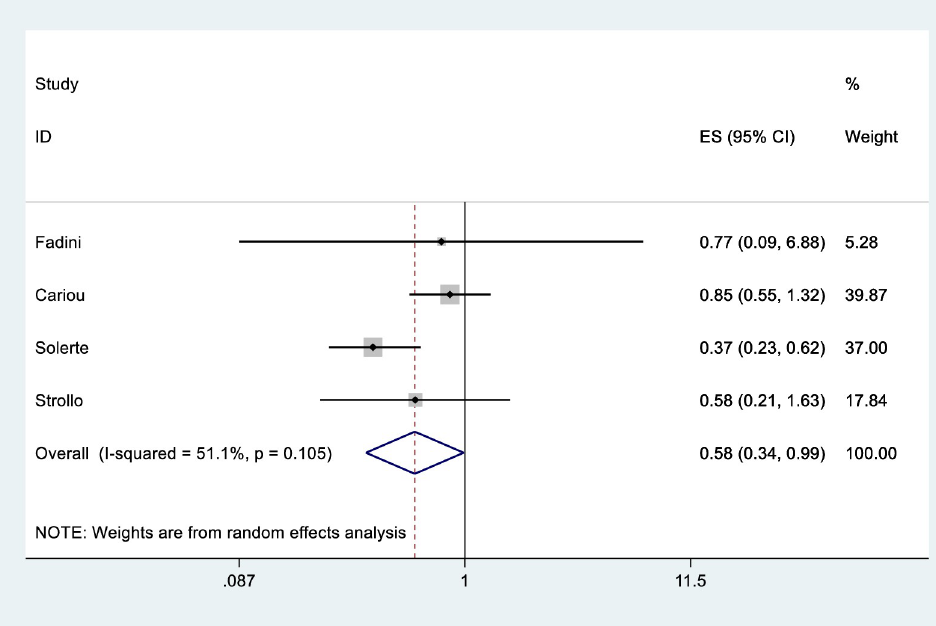
Fig 2. Forest plots of ORs for the association between the DPP-4i use and the mortality of COVID-19.